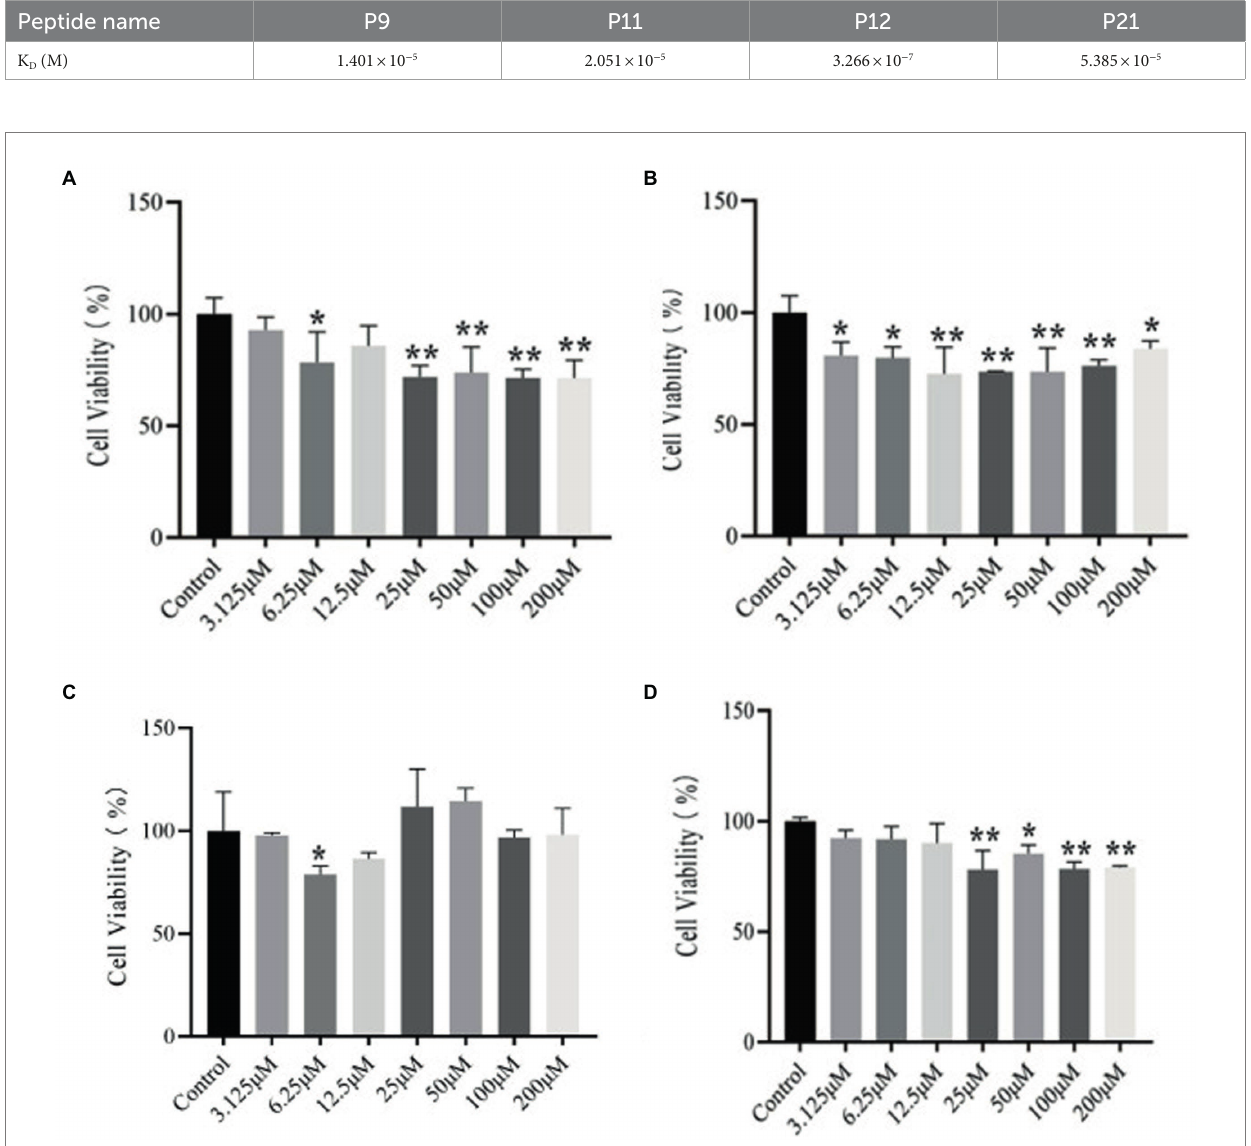
FIGURE 3 CCK-8 kit method to determine the results of different concentrations of peptides on the viability of PC12 cells. (A) P9 (B) P11 (C) P12 (D)